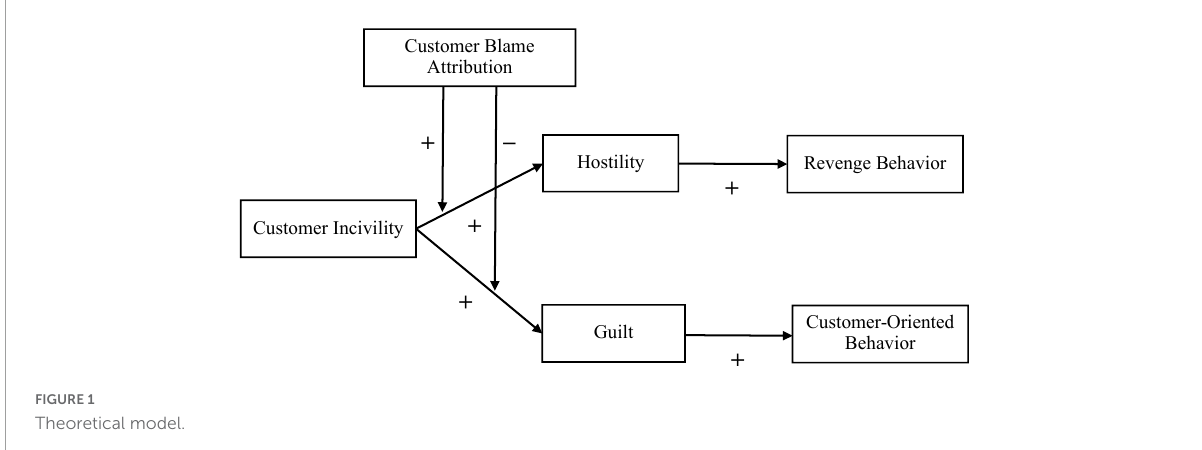
FIGURE1 Theoretical